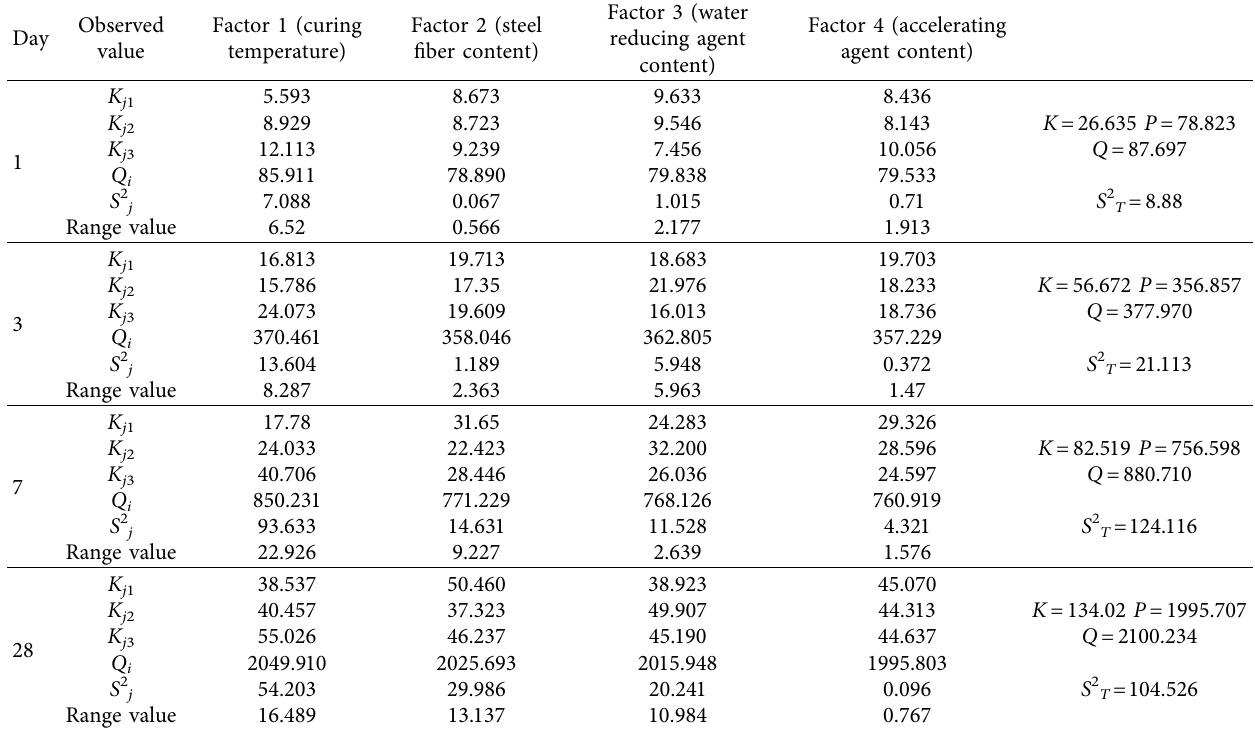
Table 3: Visual analysis table.